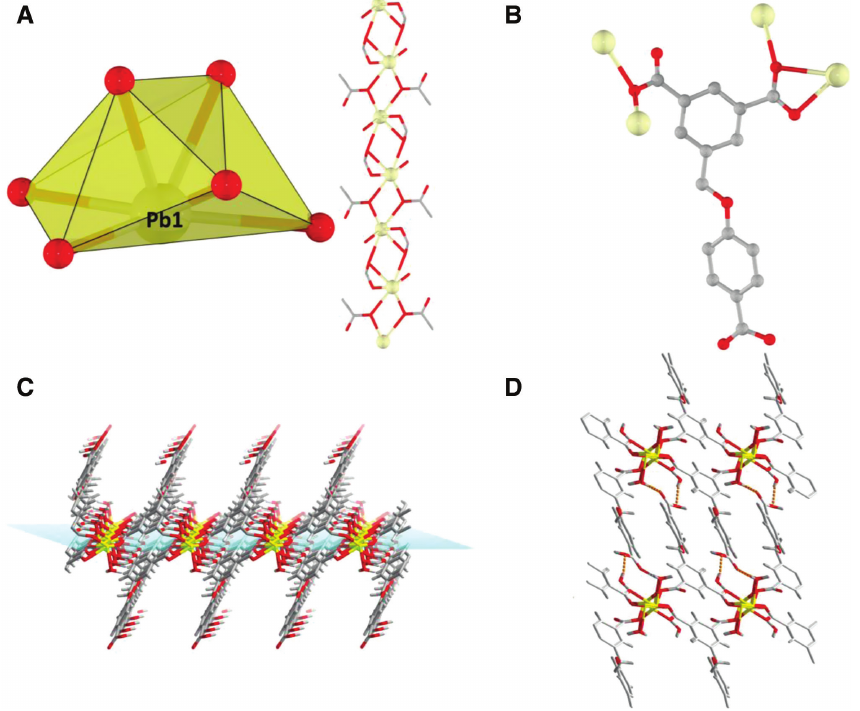
Figure 2: The crystal structures for compound 1 . (A) View for the coordination surrounding of the Pb(II) ion; (B) view for the connection modal for the HL ligand; (C) the 2D layered network of l ; (D) the 3D supermolecular framework of 1 formed by the H-bond interactions.